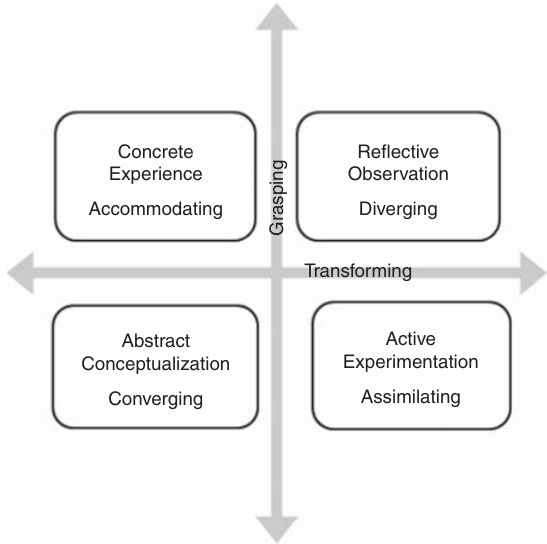
Figure 1. Experiential learning